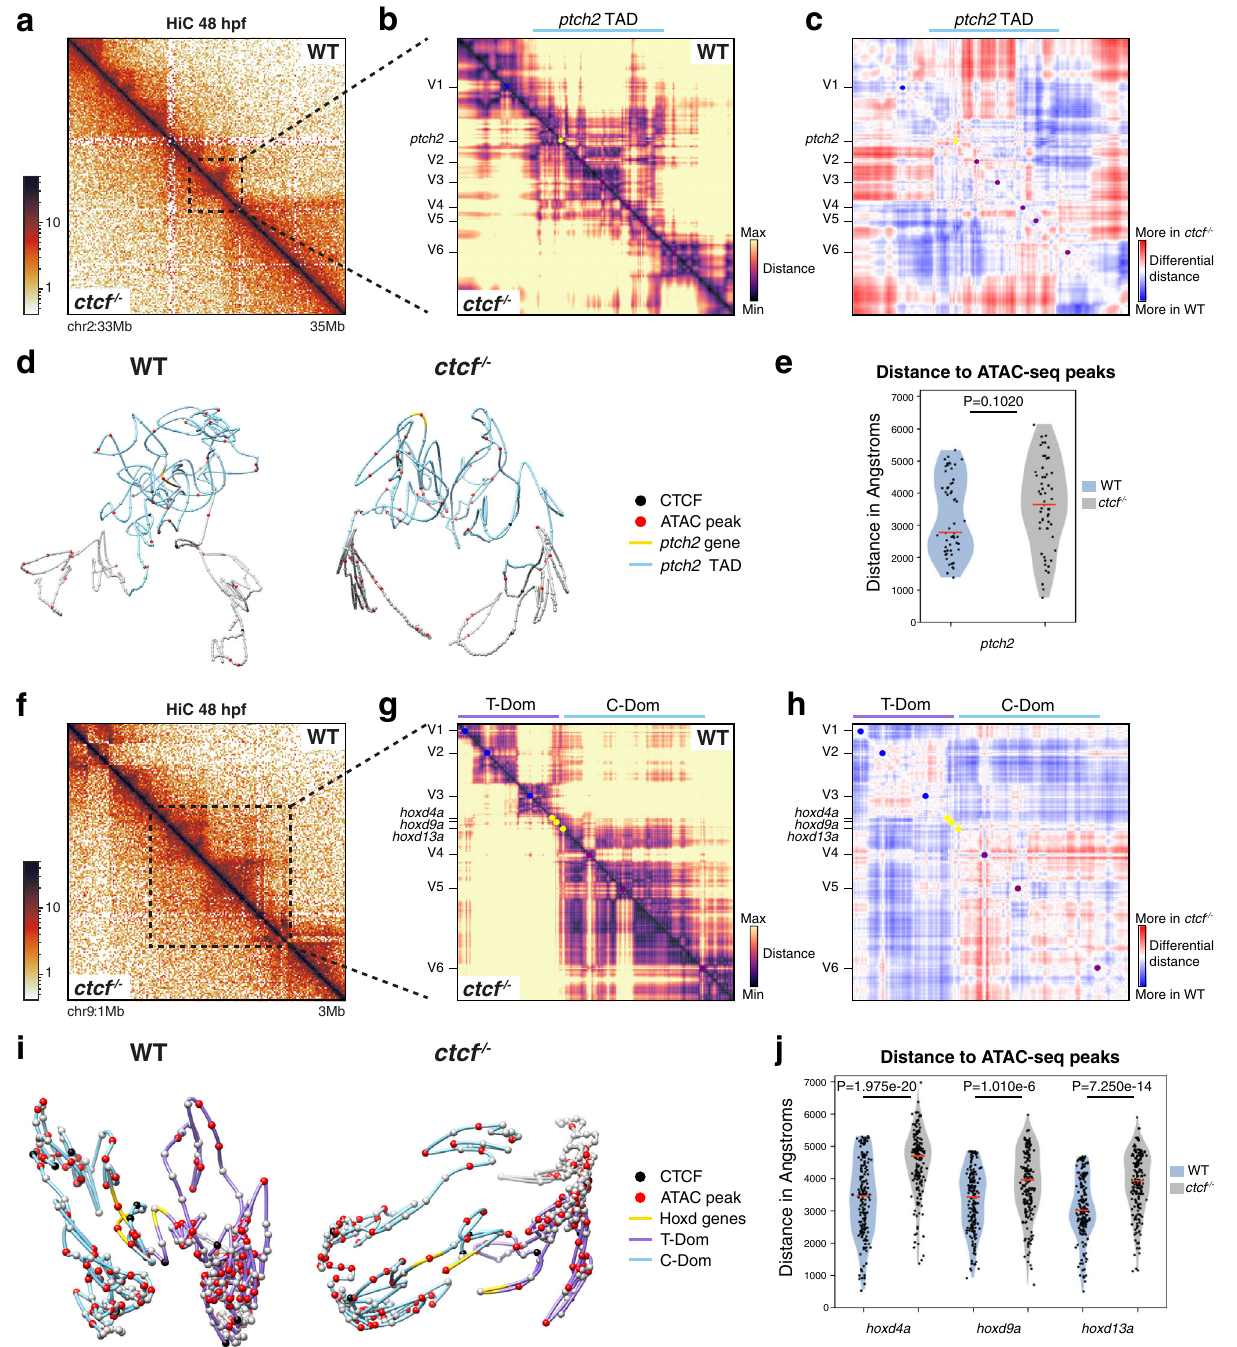
Fig. 8 3D modeling of developmental loci reveals increased distances within regulatory landscapes. a HiC normalized contact maps at 10-kb resolution from WT and ctcf − / − zebra fi sh embryos at 48 hpf. A 2-Mb genomic region in chromosome 2 containing the ptch2 locus is plotted. b Virtual HiC matrices of the ptch2 locus from WT and ctcf − / − embryos showing distances based on UMI-4C data at 48 hpf. Viewpoints, including the ptch2 promoter, are shown on the left. The TAD containing ptch2 is highlighted in light blue. c Differential distances at the ptch2 locus from ( b ), between WT and ctcf − / − embryos. d Representative models of the 3D chromatin structure of the ptch2 locus in WT and ctcf − / − embryos. e Violin plots showing the distances between ATAC- seq peaks and ptch2 promoter within ptch2 TAD. f HiC normalized contact maps at 10-kb resolution from WT and ctcf − / − zebra fi sh embryos at 48 hpf. A 2-Mb genomic region in chromosome 9 containing the HoxD cluster is plotted. g Virtual HiC matrices of the HoxD locus from WT and ctcf − / − embryos showing distances based on UMI-4C data at 48 hpf. Viewpoints, including the hoxd4a , hoxd9a , and hoxd13a promoters, are shown on the left. The two TADs (T- and C-Dom) at the HoxD locus are highlighted in light blue. h Differential distances at the HoxD locus from g, between WT and ctcf − / − embryos. i Representative models of the 3D chromatin structure of the HoxD locus in WT and ctcf − / − embryos. j Violin plots showing the distances between ATAC- seq peaks in the HoxD locus and hoxd4a , hoxd9a , and hoxd13a promoters. For e and j , statistical signi fi cance was assessed using a two-sided Student ’ s t test. *** P <